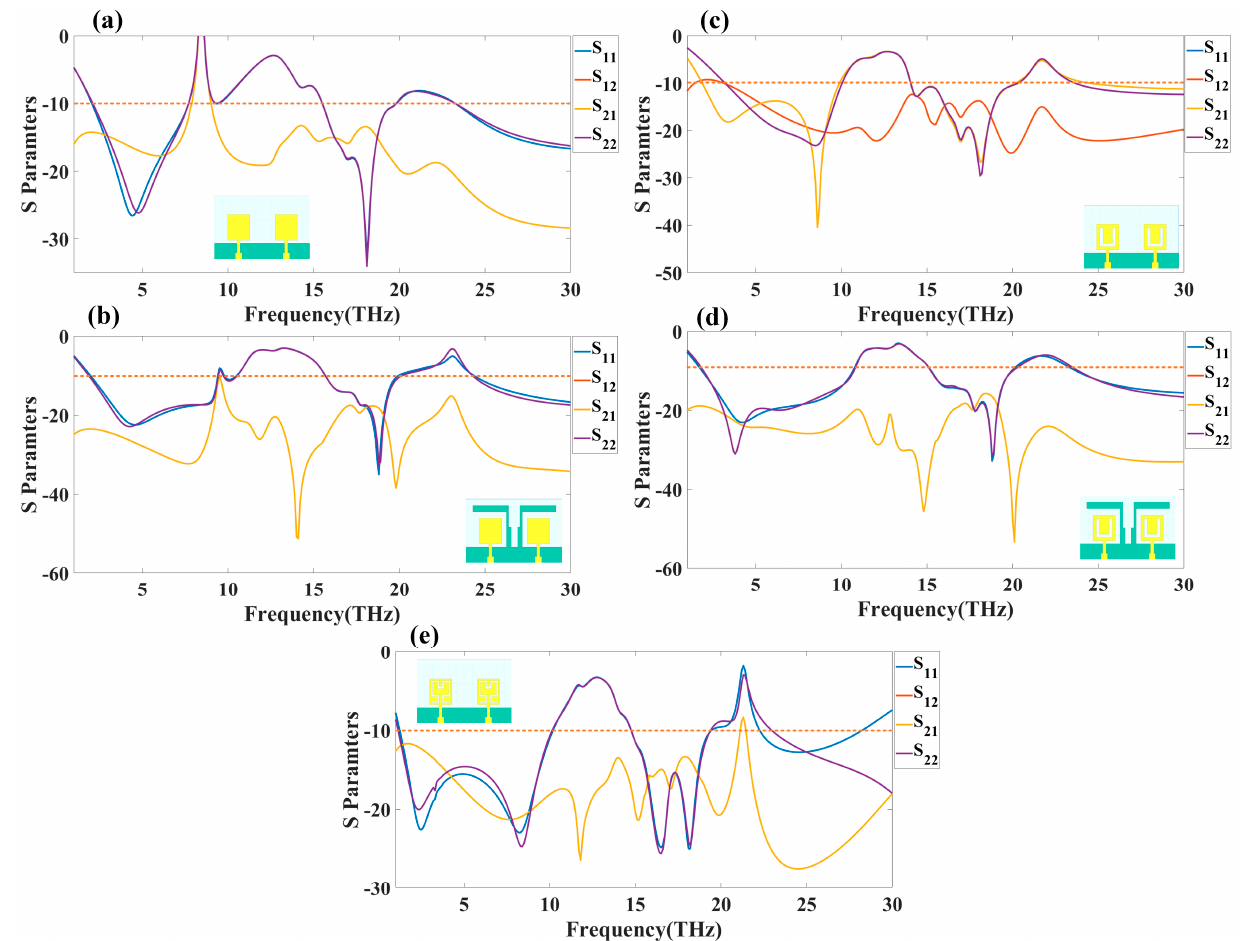
Figure 2. Calculated return loss (S parameters) for the MIMO antennas. S parameters response for ( a ) simple patch antenna with the rectangular back side (Design 1), ( b ) Simple patch antenna with modified back side with covered sides (Design 2), ( c ) Hilbert shape order 1 with the rectangular back side (Design 3), ( d ) Hilbert shape order 1 with modified back side with covered sides (Design 4), and ( e ) Hilbert shape order 2 with the rectangular back side (Design 5). Orange line is defined at − 10 dB point to measure the reference values of S 11 and S 21 .